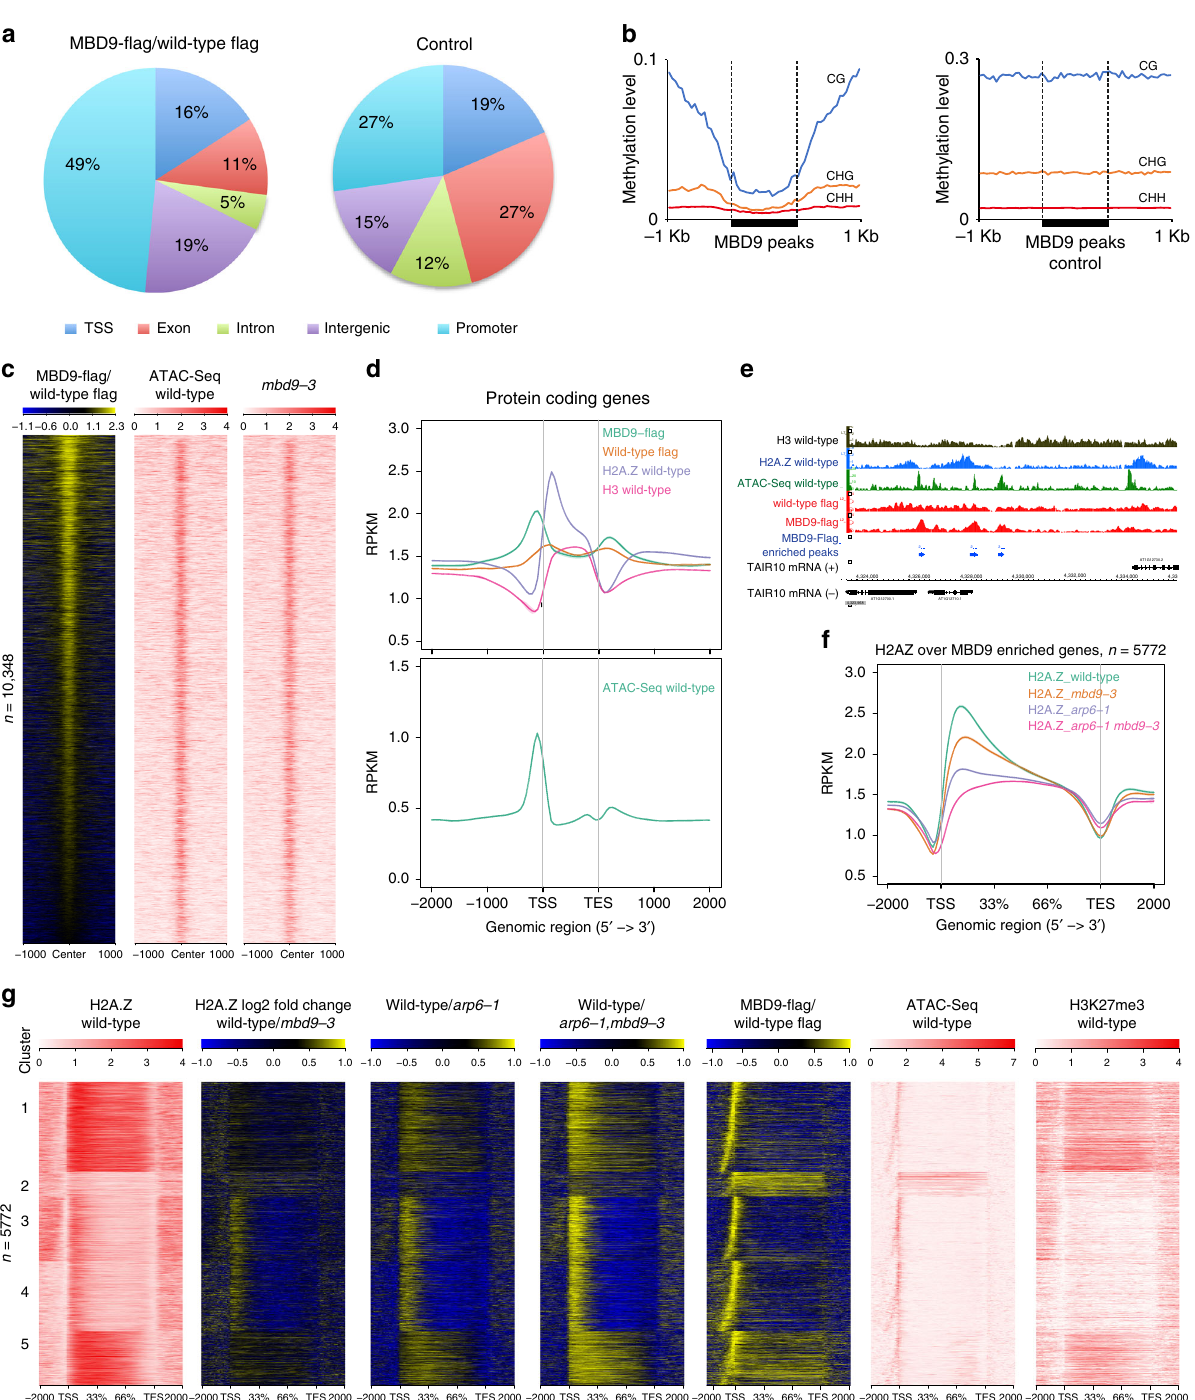
Fig. 4 Characterization of MBD9 chromatin binding. a Genomic distribution of MBD9-enriched peaks vs wild type (mac2 peak caller, q value <0.01). b Average distribution of DNA methylation levels in CG, CHG, and CHH contexts in wild type over MBD9-occupied peaks and MBD9 control peaks. c Heatmap of normalized MBD9 signal (log 2 RPKM) over wild-type control and normalized ATAC-seq signal (RPKM) from merged replicates in wild type and mbd9-3 mutant over MBD9-occupied peaks. d Upper: Distribution of normalized signal (RPKM) for MBD9-3xFlag ChIP-seq, wild-type Flag ChIP-seq control, H2A.Z, and H3 in wild type over protein-coding genes. Lower: Distribution of normalized signal (RPKM) for ATAC-seq in wild type over protein- coding genes. e Snapshot representing normalized read counts (RPKM) for MBD9-3xFlag ChIP-seq, wild-type Flag ChIP-seq control, ATAC-seq, H2A.Z, and H3. Signal for ATAC-seq, H2A.Z, and H3 is a merge of two biological replicates. f Distribution of normalized H2A.Z ChIP-seq signal (RPKM) from merged replicates in wild type, mbd9-3, arp6-1 , and arp6-1 mbd9-3 over MBD9-occupied genes. g Heatmap ordered based on k -means clustering of H2A.Z ChIP-seq signal in wild type (cluster n = 5) at MBD9-occupied genes. Shown are corresponding H2A.Z ratio plots for wild type over mbd9-3 , arp6-1 , and arp6-1 mbd9-3 mutants and MBD9-3X Flag ChIP-seq over wild-type fl ag control in log 2 RPKM, ATAC-seq in wild type in RPKM, and H3K27me3 levels in wild type in RPKM. Source data are provided as Source Data fi